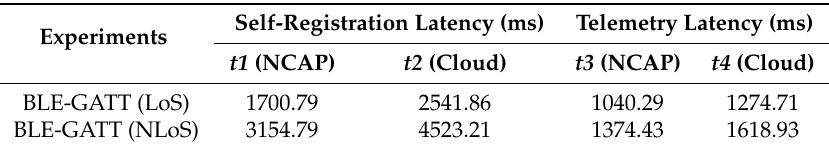
Table 4. Self-registration and telemetry latencies for the NLoS